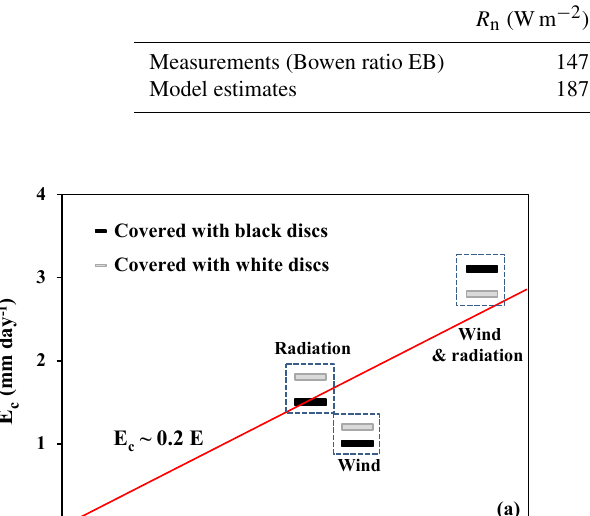
Table 2. Comparison of modeled and measured annual surface energy balance components for (uncovered) Lake Mead (2010–2011).